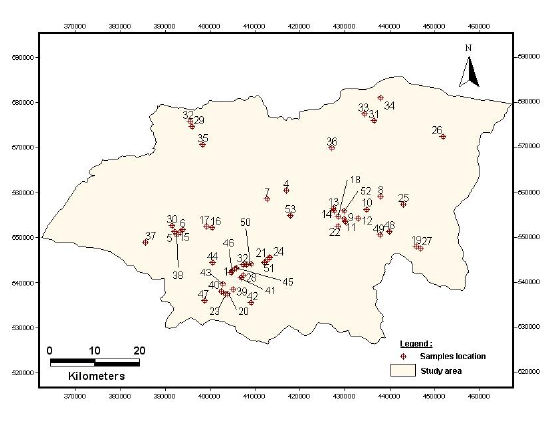
Figure 2. Locations of water samples in the study area.